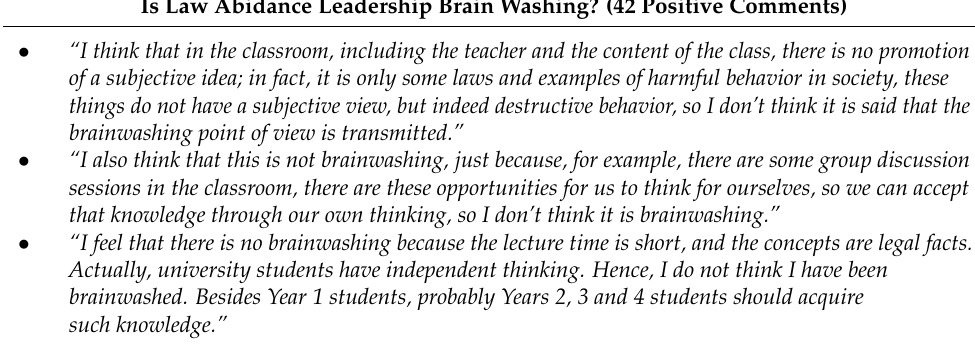
Table 6. Narratives of positive views on whether law abidance leadership education is